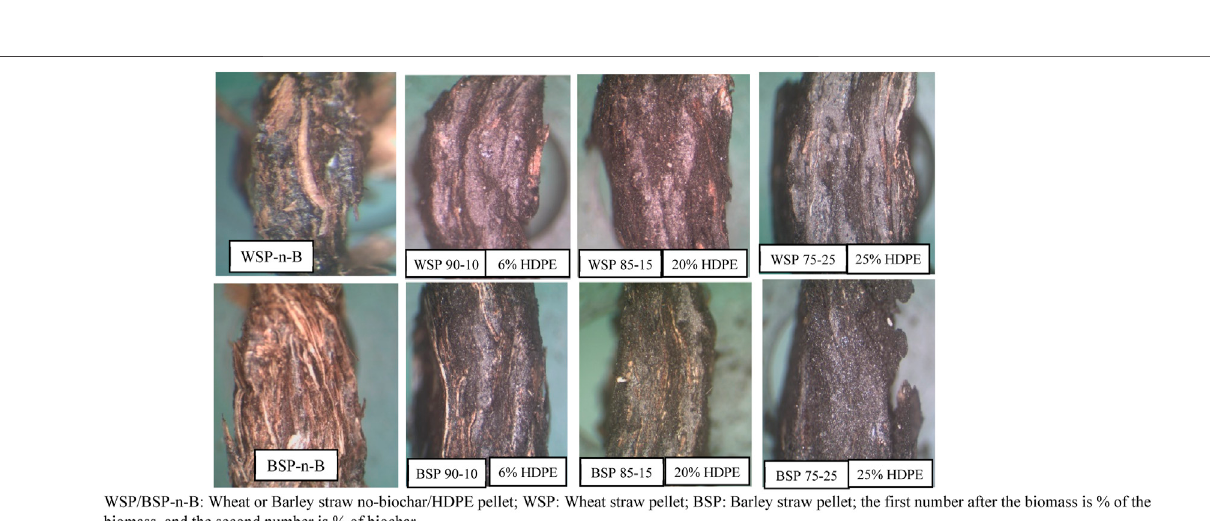
Frontiers in Energy Research |